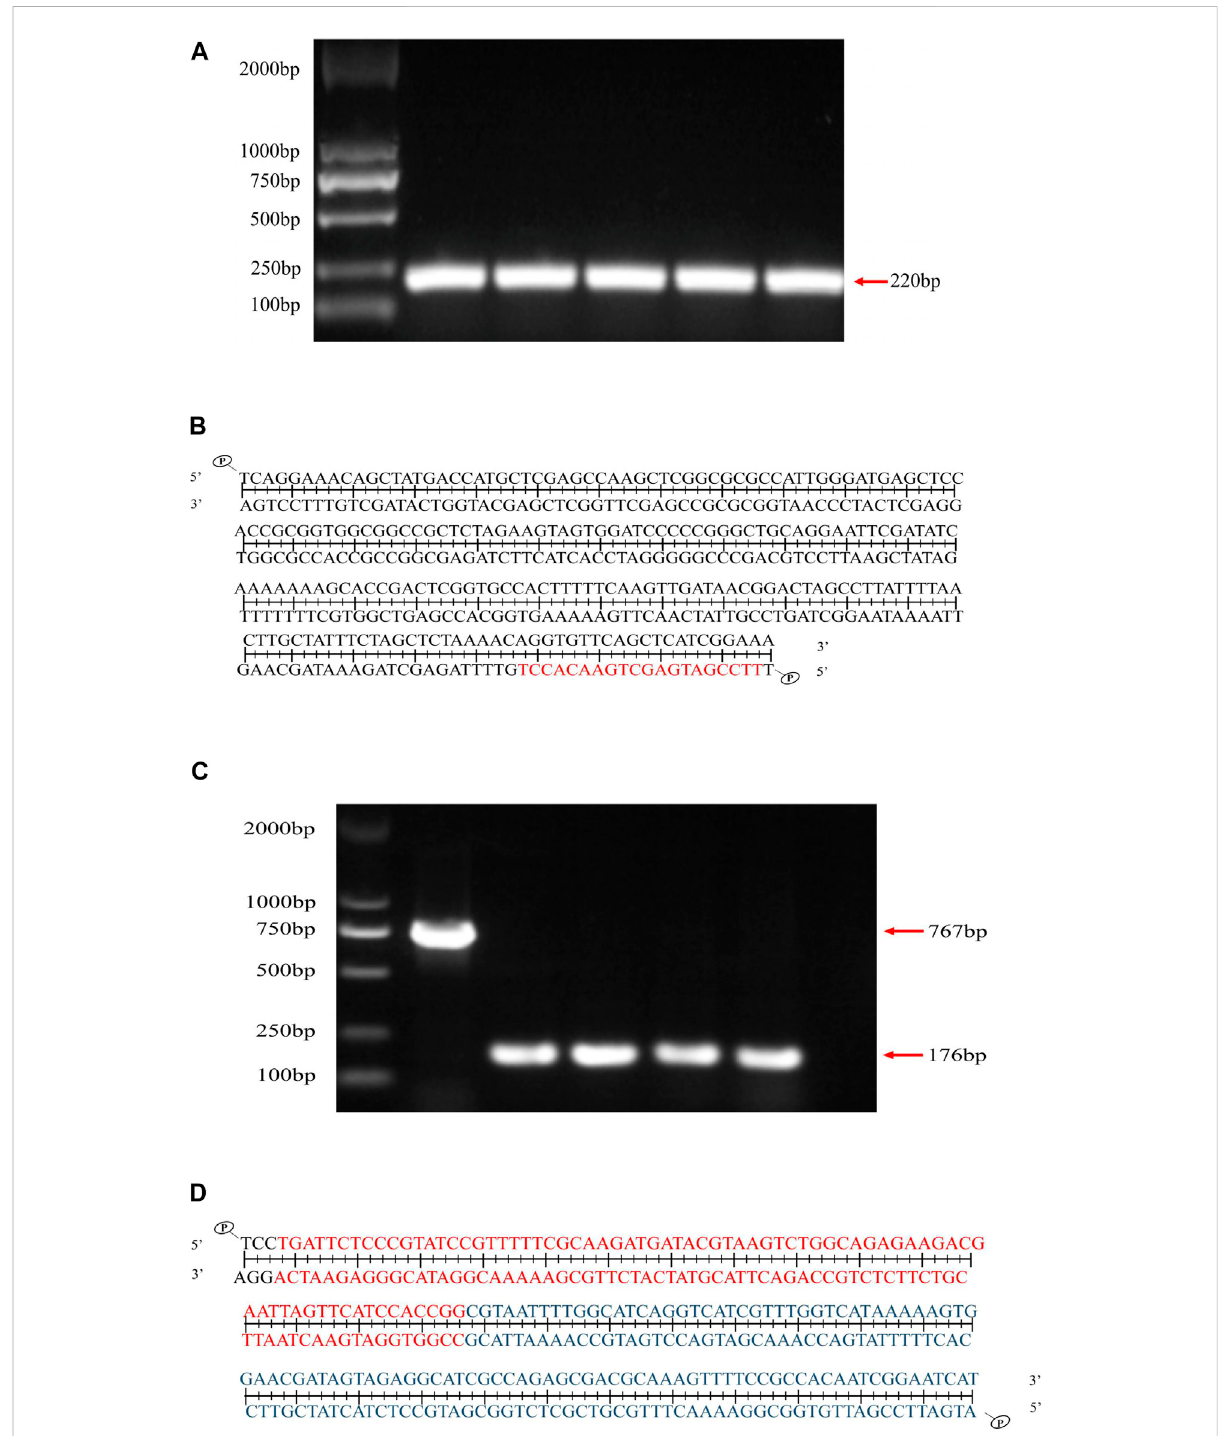
Veri fi cation of ygiM deletion mutant by PCR and sequencing. (A) The pSGKP plasmid contains YgiM protein N20, and the target band is 220bp afterPCRveri fi cation. (B) SangersequencingindicatedthatthepSGKPplasmidcontainingYgiMproteinN20wassuccessfullyconstructed(redbases represent N20). (C) PCR con fi rmed that the ygiM mutant was constructed successfully. (D) Sanger sequencing veri fi ed that ygiM was successfully knocked out. (Red bases represent upstream of ygiM and blue bases represent downstream of ygiM